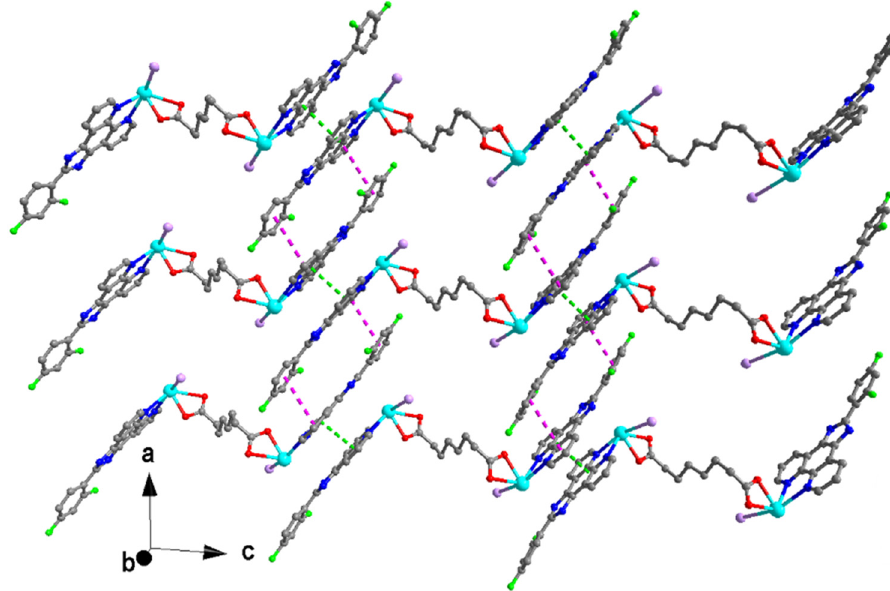
Figure 5: View of the 2D supramolecular layer structure of 1 formed by two π – π